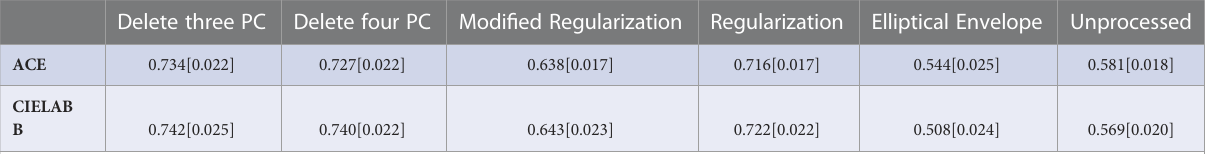
TABLE 1 Average Area Under the Curve (AUC) and [standard